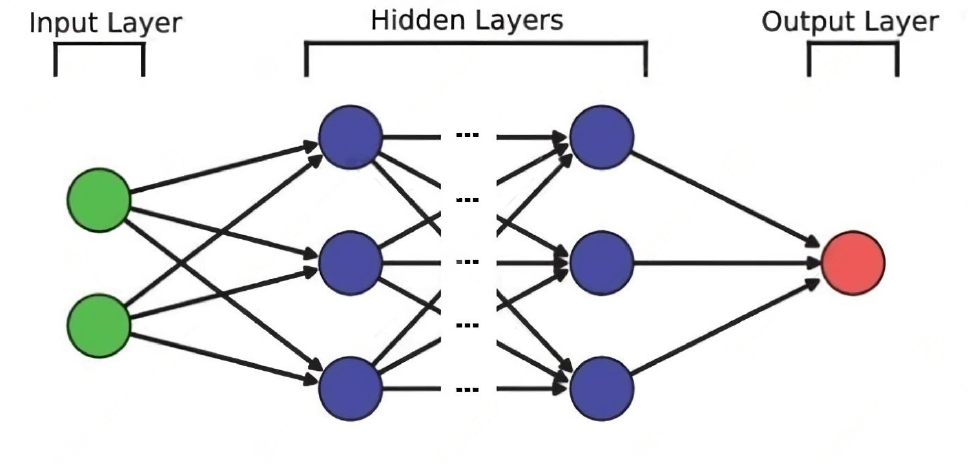
Figure 4. Standard ANN scheme with multiple hidden layers for two inputs and one